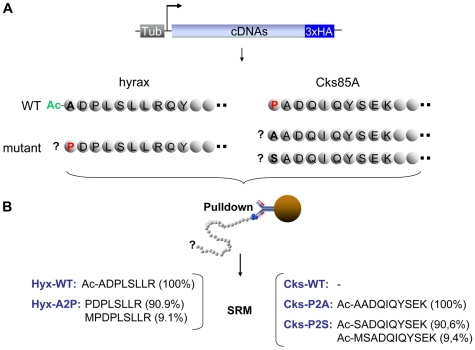
Workflow to test the (X)PX rule.(A) The cDNAs of hyrax (hyx) and cks85A were modified as follows: in the Drosophila hyx cDNA the codon for the secondary Ala was replaced by a Pro to prevent acetylation of the amino-terminus. Similarly, we replaced the codon for the secondary Pro in the Drosophila cks85A cDNA by either a Ser or an Ala to promote acetylation. In addition, all constructs were C-terminally HA-tagged and subjected to the control of the tubulin-1α promoter. The different constructs subsequently express Hyx-A2P-HA, Hyx-Wt-HA, Cks-P2A-HA, Cks-P2S-HA, and Cks-Wt-HA, respectively. (B) To test the (X)PX rule in vitro transient transfections of S2 cells were performed. The tagged proteins were isolated via immunoprecipitation and subjected to mass spectrometry analysis via SRM. As expected, the N-terminus of Hyx-Wt-HA was found to be acetylated in combination with a complete iMet removal. In contrast, the amino terminus of Hyx-A2P-HA was always unmodified but showed partial iMet cleavage (9.1%). For both kinase mutants Cks-P2A-HA as well as Cks-P2S-HA the N-Terminus is always acetylated. For Cks-P2S-HA we also detected the acetylated peptide MSADQIQYSEK caused by an incomplete iMet removal (9.4%). Cks-Wt-HA could not be detected due to toxicity effects of the expressed transgene but has initially been isolated via COFRADIC with a free N-terminus.